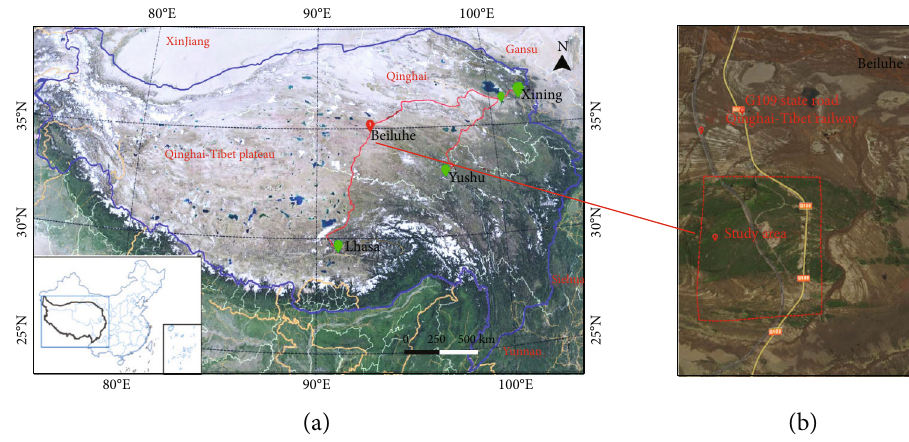
Figure 1: Schematic location of the study site (from LocaSpaceViewer).